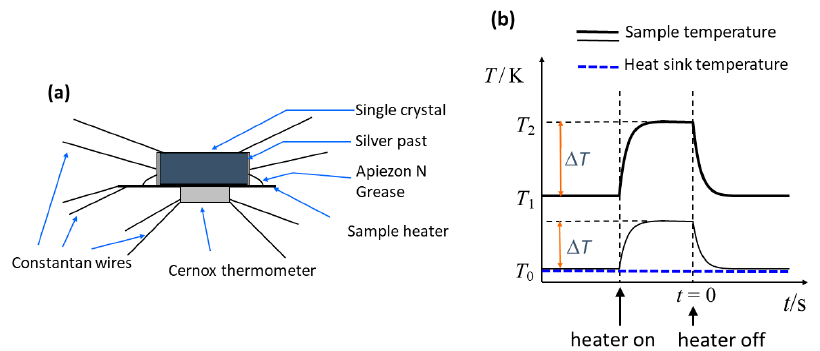
Figure 2. ( a ) Schematic illustration of the sample part of the relaxation calorimetry cell. Four lead wires are attached on the surfaces of the single crystal for applying current and voltage. ( b ) The temperature profiles against time for the standard and the modified relaxation calorimetry technique. The lower curve shows the heating and relaxation curve for the standard relaxation calorimetry. The upper one shows the case with constant currents or voltages applied for the crystal.